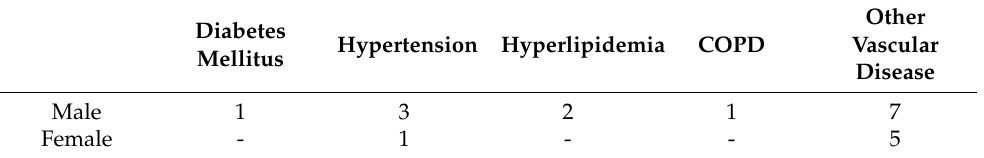
Table 3. The table shows the main morbidities in the analyzed population relative to gender. Only the most frequent conditions in the general population were chosen. Absolute counts of individual pathologies were considered, and a single case may involve multiple comorbidities. In the fourth column, COPD means “chronic obstructive pulmonary disease”. In the last column, under “other vascular disease,” only aneurysms, valvopathies, and myocardiopathies were considered. Coronary artery disease or diffuse vascular disease were not considered because if patients required a graft, we implied that all had ongoing coronary artery